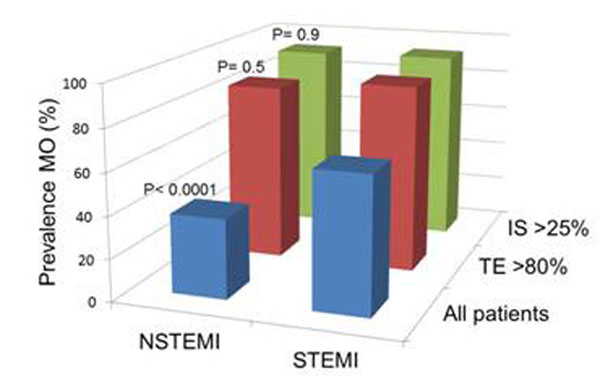
The prevalence of MO for NSTEMI and STEMI in all patients, patients with IS >25% (upper tertile) and patients with transmural extent (TE) >80% (upper tertile).